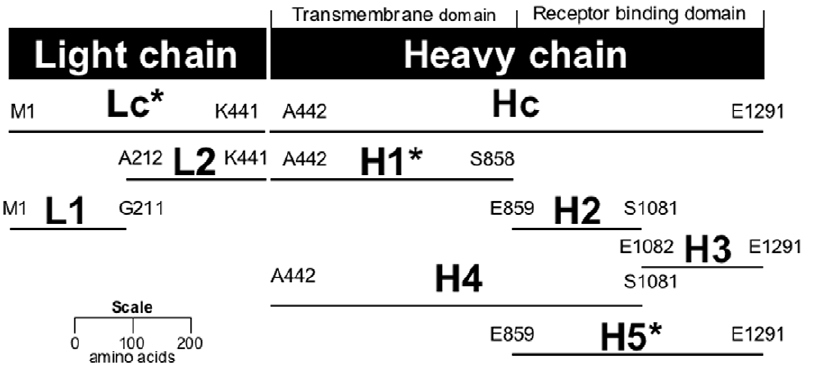
Figure 1. Peptide fragments of BoNT/B light and heavy chains. Diagram is drawn to scale to facilitate size and location comparison between peptide fragments. The transmembrane (A442 to S858) and receptor-binding (E859 to E1291) domains are indicated [27]. Peptide fragments were expressed as fusions to GST at the N-terminal. N- and C-terminal amino acids of each peptide fragment are indicated. Fragments used as antigens to generate monoclonal antibodies in mice are indicated with an asterisk.